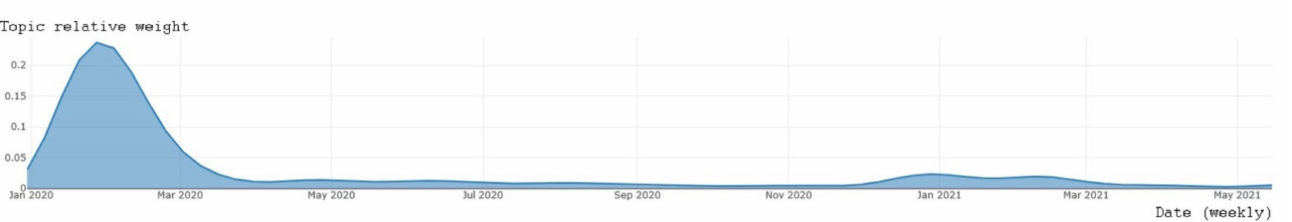
Figure 6. Weekly smoothed dynamics of “China, Coronavirus, New, Chinese, Wuhan” topic relative